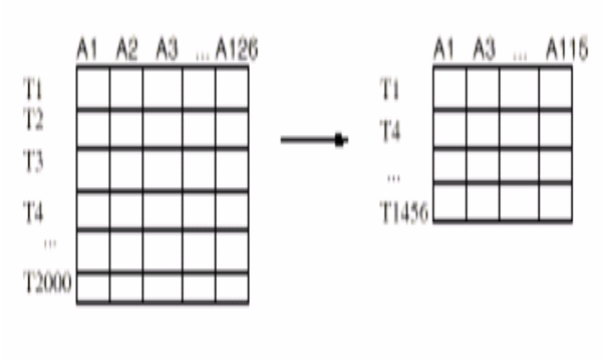
[Figure 5: Data reduction process]